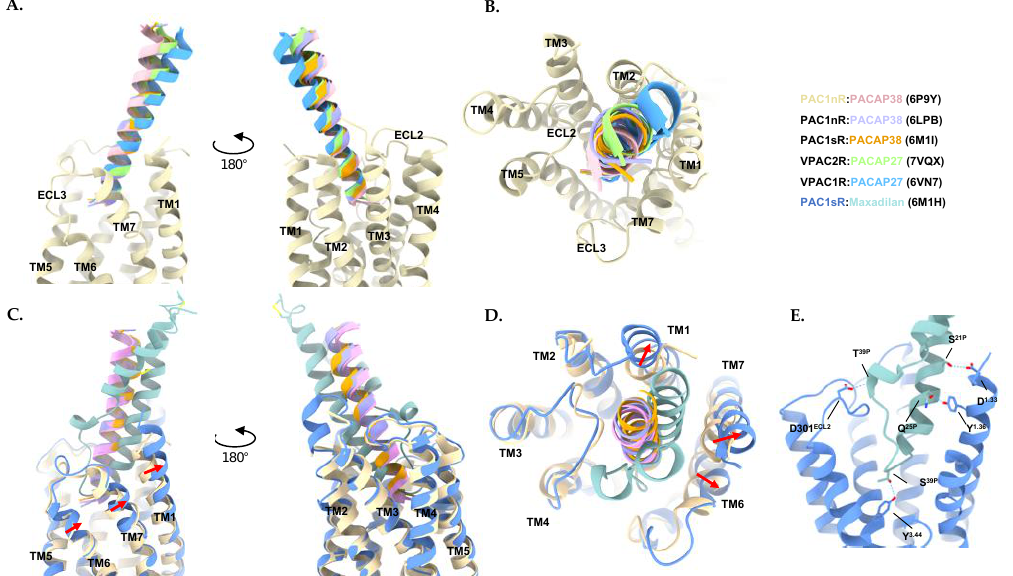
Figure 4. Comparison of peptide binding mode to receptors of the PACAP subfamily. ( A ) Side views and ( B ) Top view of the superimposed structures of PACAP bound to VPAC1R, VPAC2R, and PAC1R. Only the transmembrane (TM) helices of the receptor chain of PAC1nR (PDB: 6P9Y) are shown for reference/clarity. ( C ) Side views and ( D ) Top view of the superimposed structures of maxadilan and PACAP bound to PAC1R reveals TM1, 6, and 7 shifted outward to accommodate maxadilan (PDB: 6M1H) when compared to the PACAP38-bound PAC1nR (PDB: 6P9Y). Movement of the TMs indicated by red arrows. Only the TM helices of the receptor chain of the PACAP38- bound PAC1nR (PDB: 6P9Y) and the TM helices of the receptor chain for the maxadilan-bound PAC1sR (PDB: 6M1H) are shown for reference/clarity. ( E ) Helix 1 of maxadilan forms hydrogen bonds with TM1 in the peptide binding pocket while the loop of maxadilan and helix 2 forms hy- drogen bonds with ECL2 and TM3. Structure is shown as a side view with a focus on the receptor core. Hydrogen bonds calculated with ChimeraX 1.3. Structures were aligned by receptor chains and displayed as ribbons, with residues involved in hydrogen bonds (dotted lines) shown as sticks using ChimeraX 1.3 [310,311]. Colors for the peptides and receptors are shown in the figure. Peptide residues are denoted with superscript P, extracellular loop residues are denoted as ECL. Receptor transmembrane residues are denoted using the Wootten numbering system. While the PAC1R structures were determined bound to PACAP38, the VPAC1R and VPAC2R were bound to PACAP27. However, due to the high mobility of the PACAP C- terminus in PACAP38-bound structures, only the first 27 residues were modeled. When comparing these structures, the interactions of the first three residues of the relevant PA- CAP with the receptor core of the VPAC1R, VPAC2R, and PAC1R (Figure 5A – C), from studies of alanine substituted peptides, the N-terminal His 1P (superscript is the residue number of the peptide) and Asp 3P residues are crucial for binding affinity and biological activity of the peptide for all three receptor subtypes [142,312,313]. This is reflected in the extensive, conserved, hydrophobic contacts between His 1P and the receptor TM3 and TM5